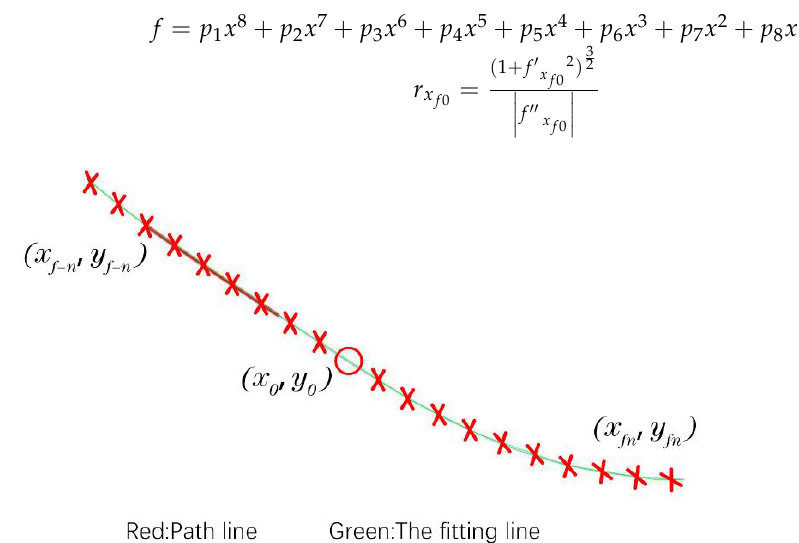
Figure 16. The principle of removing points at the corner. ( a ) Track points that make up the curve whose curvature radius is less than R min ., ( b ) track after removing the points, causing the track cur- vature radius to be less than R min ., ( c ) first-order transition curve replaces the removed the points.